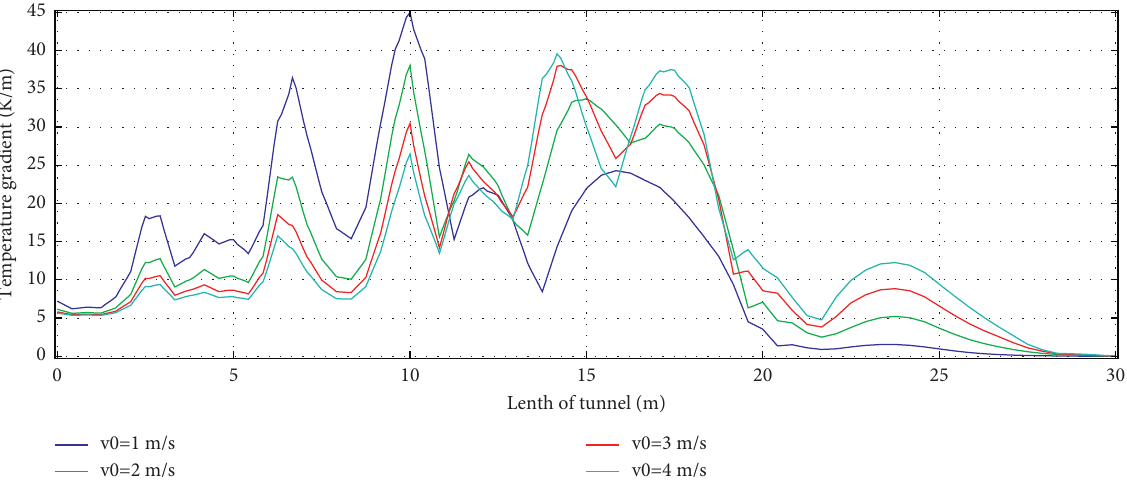
Figure 9: Gradient of air temperature distribution inside the tunnel at different wind